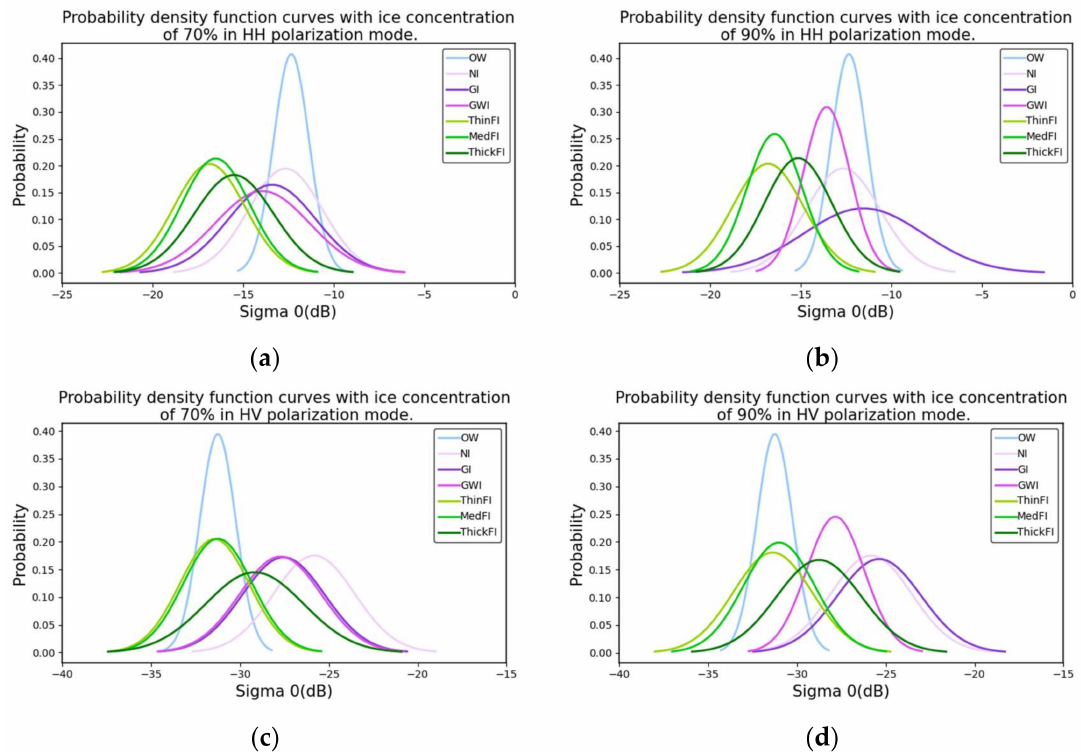
Figure 10. Probability density function curves of different ice types at different concentrations. In the HH polarization mode, ice concentration is ( a ) 70% and ( b ) 90%; in the HV polarization mode, ice concentration is ( c ) 70% and ( d ) 90%. Note: Since the OW has no concentration information, its data is the same under the same polarization mode; NI can account for up to 70% of the total ice volume, so in ( b , d ) the concentration of NI is the same 70%; the concentration of GI in ( b , d ) is